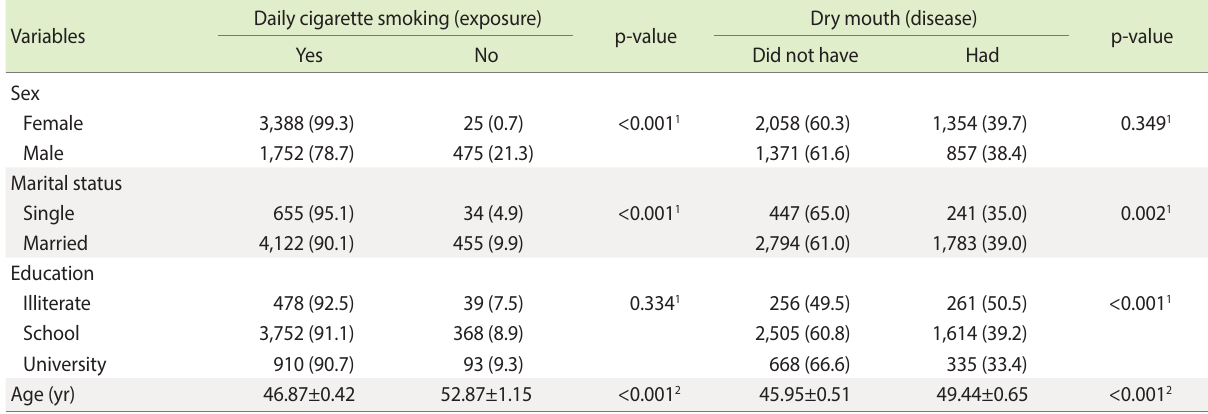
Table 1. Comparison of demographic variables of smokers and non-smokers, and people with dry mouth and without dry mouth Variables